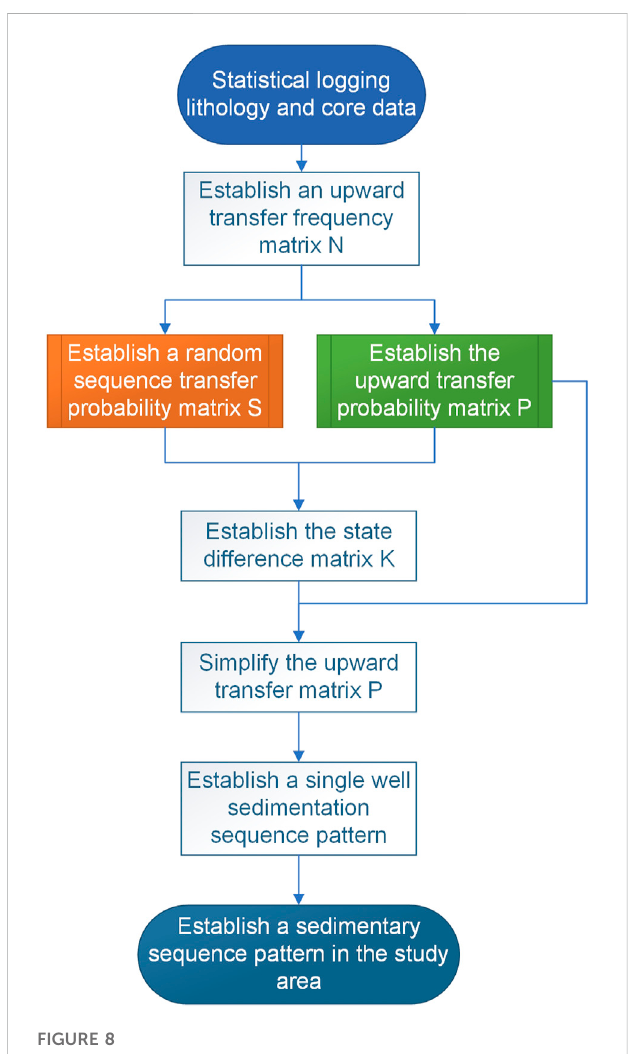
FIGURE 8 Sedimentation modeling process in the Moxizhuang